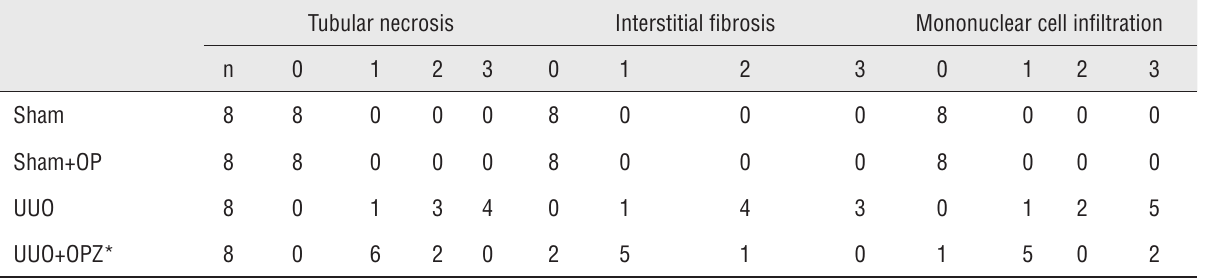
Table 2 - Scoring of tubular necrosis. Tubular necrosis Interstitial fibrosis Mononuclear cell infiltration